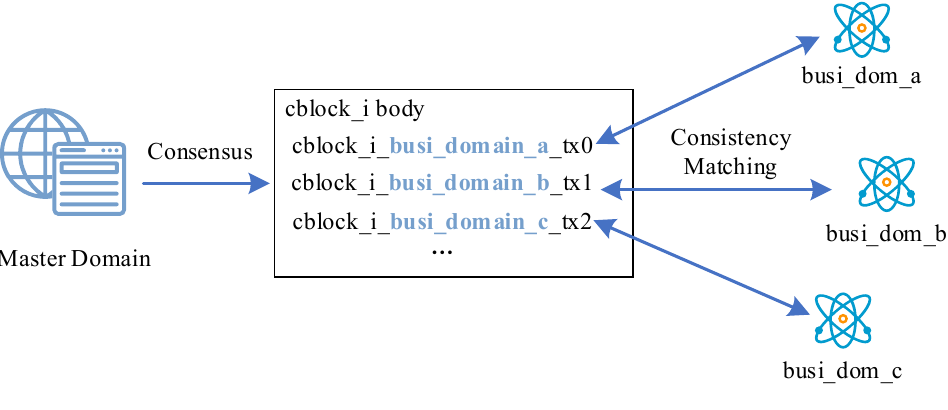
Figure 9. Consistency